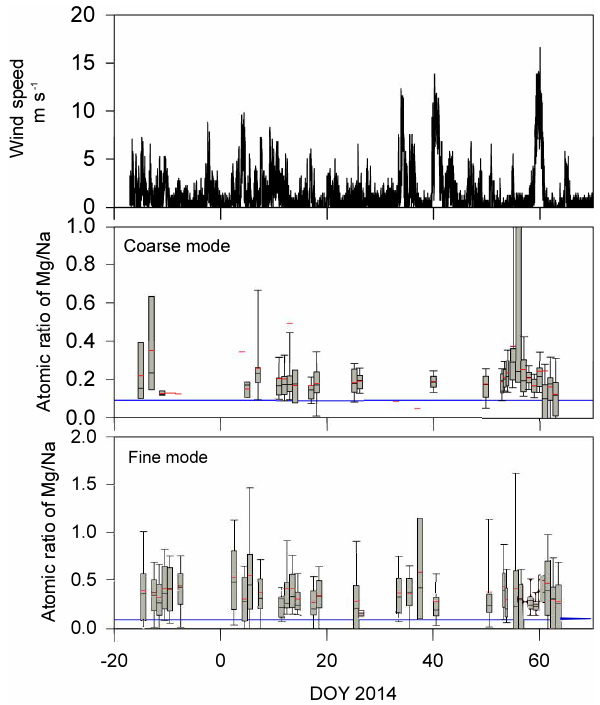
Figure 11. Variations of wind speed and atomic ratios of Mg / Na in sea-salt particles and the modified sea-salt particles collected over the sea-ice area. The box plots show values of 90, 75, 50 (median), 25, and 10% denoted, respectively, with the top bar, top box line, black middle box line, bottom box line, and bottom bar. The red lines show mean values of the seawater Mg / Na